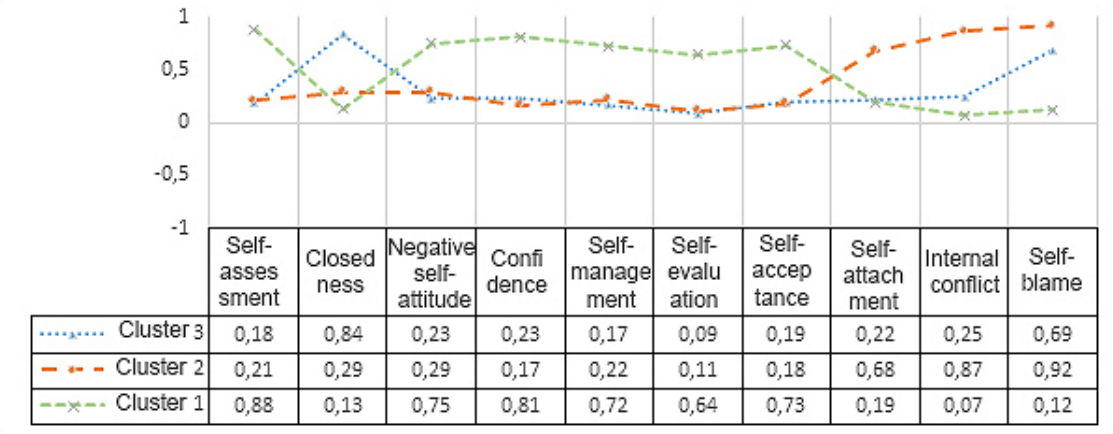
Figure 1. Indicators of self-attitude in